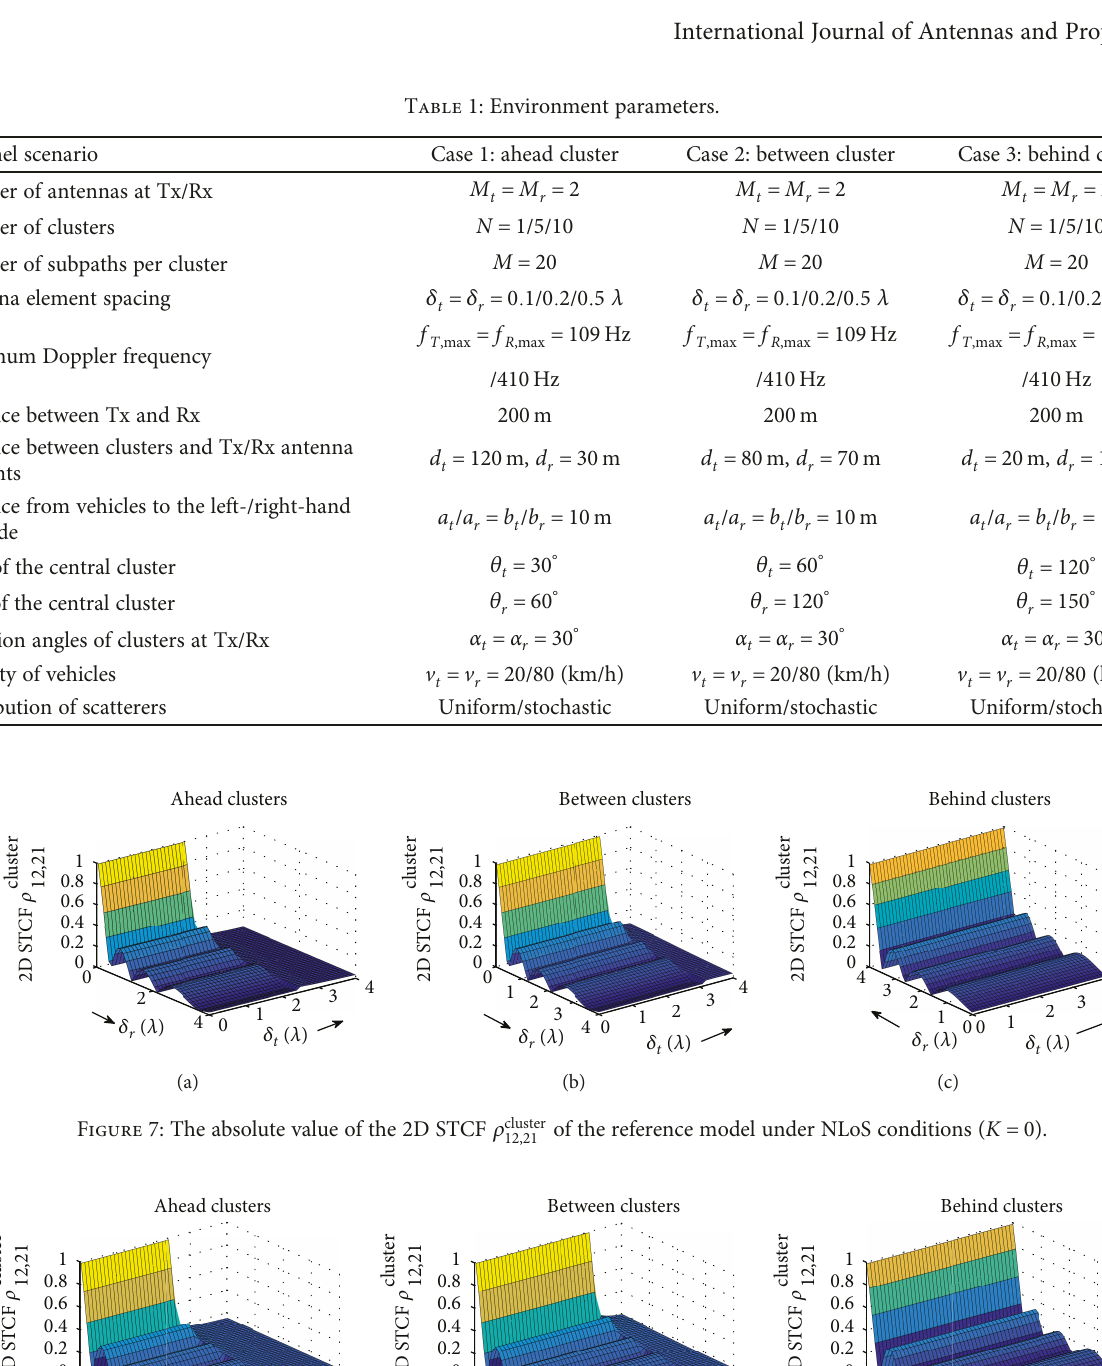
Figure 8: The absolute value of the 2D STCF ρ cluster